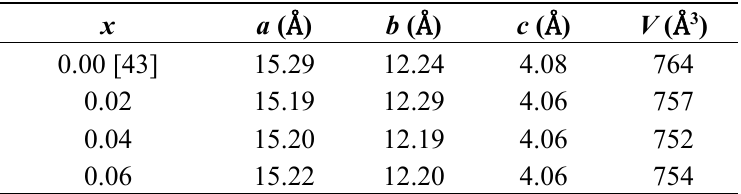
Table 9. The lattice parameters of In 4 Pb 0.01 Sn 0.03 Se 2.9 Cl x ( x = 0.0, 0.02, 0.04, and 0.06) polycrystalline compounds